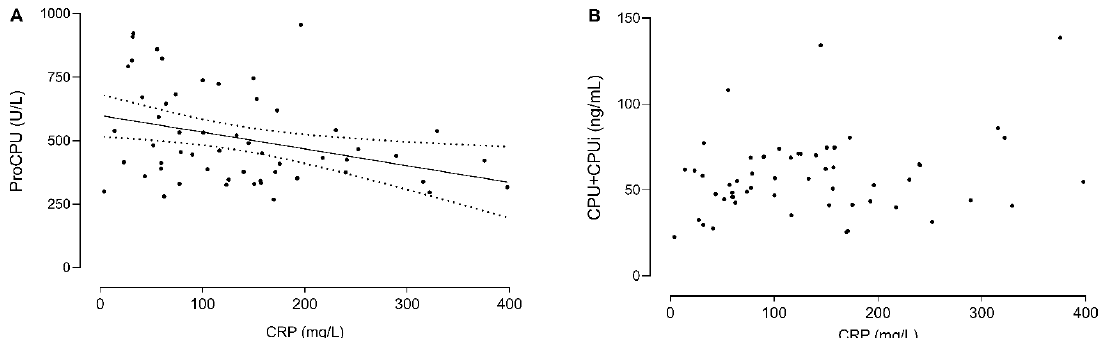
Figure 3. Relationship between the highest recorded CRP levels and corresponding proCPU levels ( A ) or CPU+CPUi antigen levels ( B ). For the majority of the patients, the highest CRP value was measured within one week after enrolment in the study. Spearman correlation coefficient r was determined for both correlations. In case of a significant correlation ( p > 0.05), linear regression analysis was performed, and the best-fit line (solid line) with 95% confidence bands was plotted (dashed lines). Thus, there is a correlation between the ongoing inflammation in SARS-CoV-2 infec-